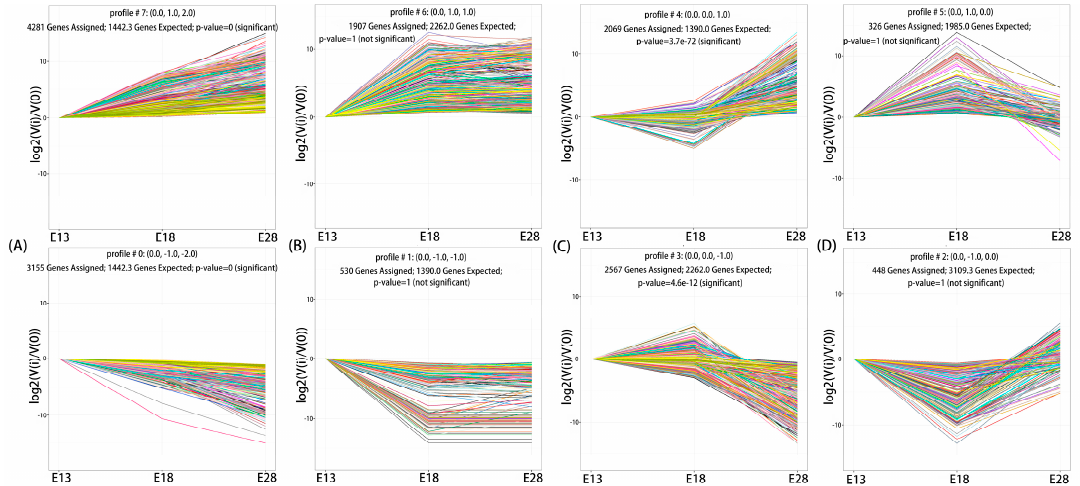
Figure 6. The four cluster trajectory profiles with two antagonistic profiles of DEGs. ( A ) Model profile A, including profiles #7 and #0. ( B ) Model profile B, including profiles #6 and #1. ( C ) Model profile C, including profiles #4 and #3. ( D ) Model profile D, including profiles #5 and #2. Each X -axis indicates the feather follicles development state (E13, E18, and E28); Y -axis shows expression changes.